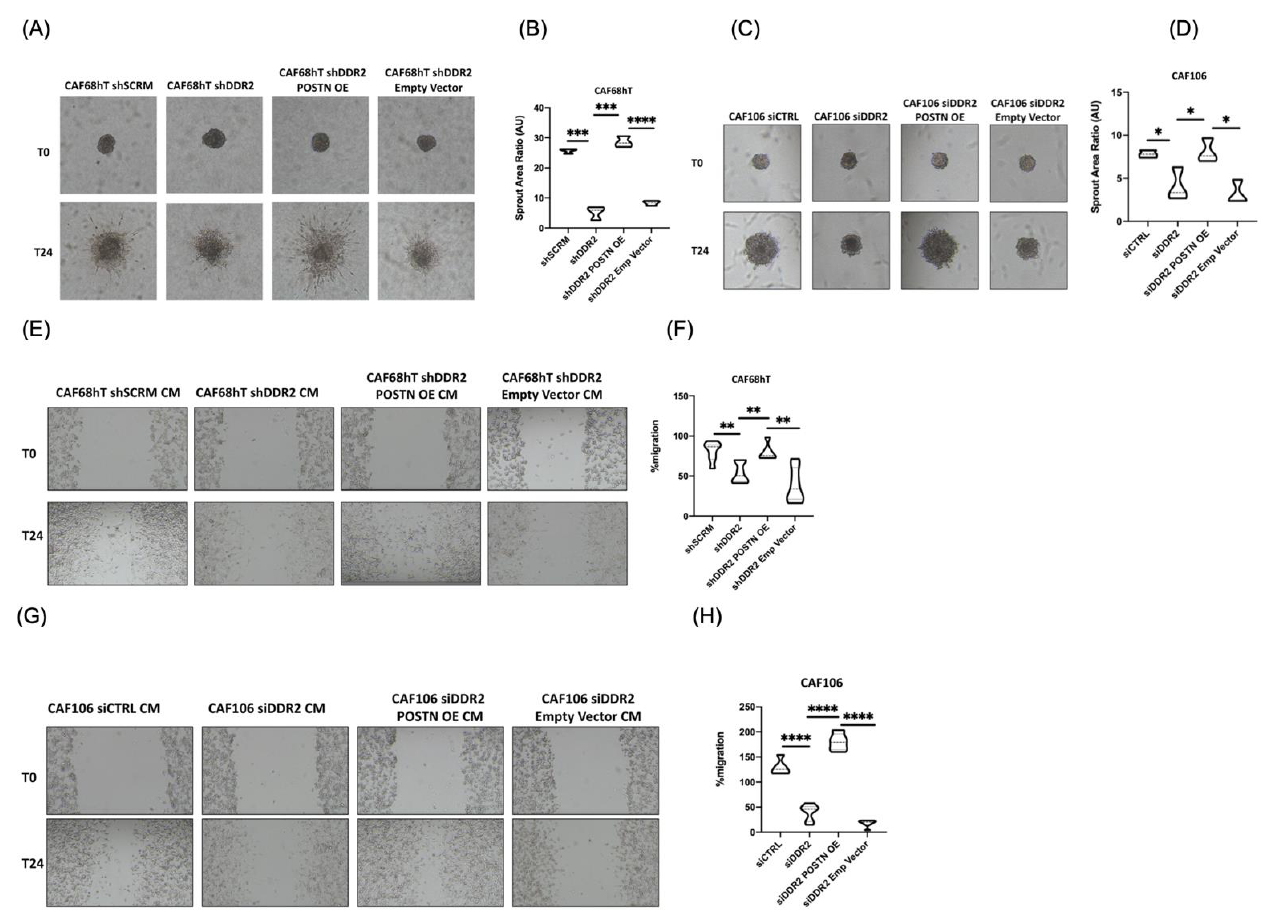
Figure 4. DDR2 and POSTN promote tumor migration and spreading. ( A ) Increased tumor spheroid spreading with POSTN overexpression in DDR2-depleted CAF68hT in collagen 1 gel. ( B ) Analysis of assay in ( A ). ( C ) Increased tumor spheroid spreading with POSTN overexpression in DDR2-depleted CAF106 in Matrigel. ( D ) Analysis of assay in ( C ). ( E ) Increased tumor migration and wound healing with POSTN overexpression in DDR2-depleted CAF68hT. ( F ) Analysis of assay in ( E ). ( G ) Increased tumor migration and wound healing with POSTN overexpression in DDR2-depleted CAF106, and ( H ) Analysis of assay in ( G ). * p < 0.05, ** p < 0.01, *** p < 0.001, **** p <